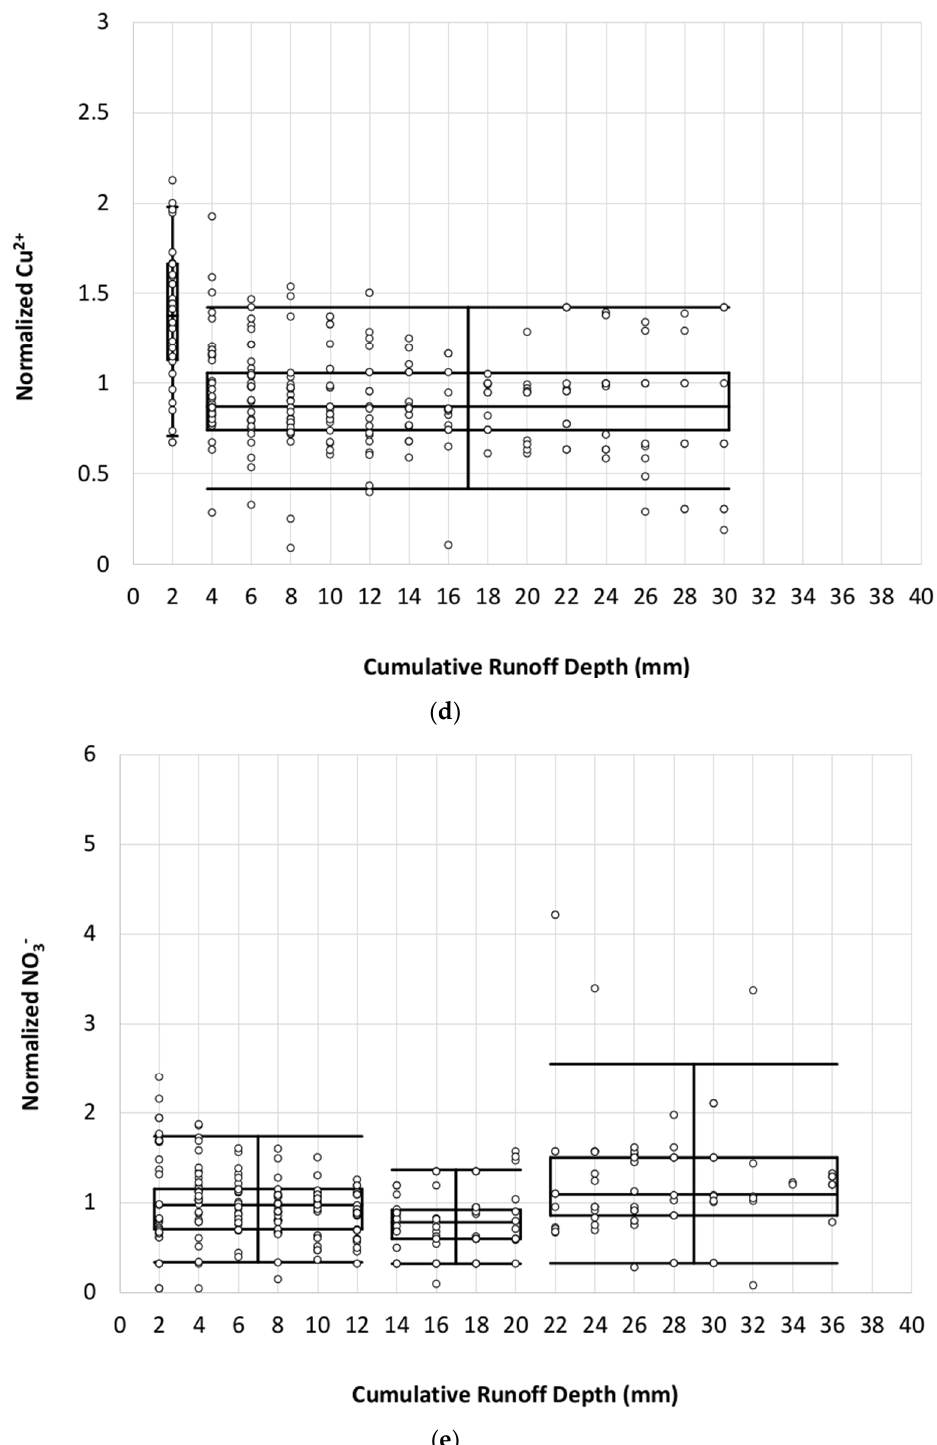
Figure 4. Bach method grouped box and whisker plots of normalized pollutant concentrations vs. cumulative runoff depths for Second Creek site. ( a ) Fecal coliform, ( b ) E. coli , ( c ) TSS, ( d ) Cu 2+ , and ( e ) NO 3− .